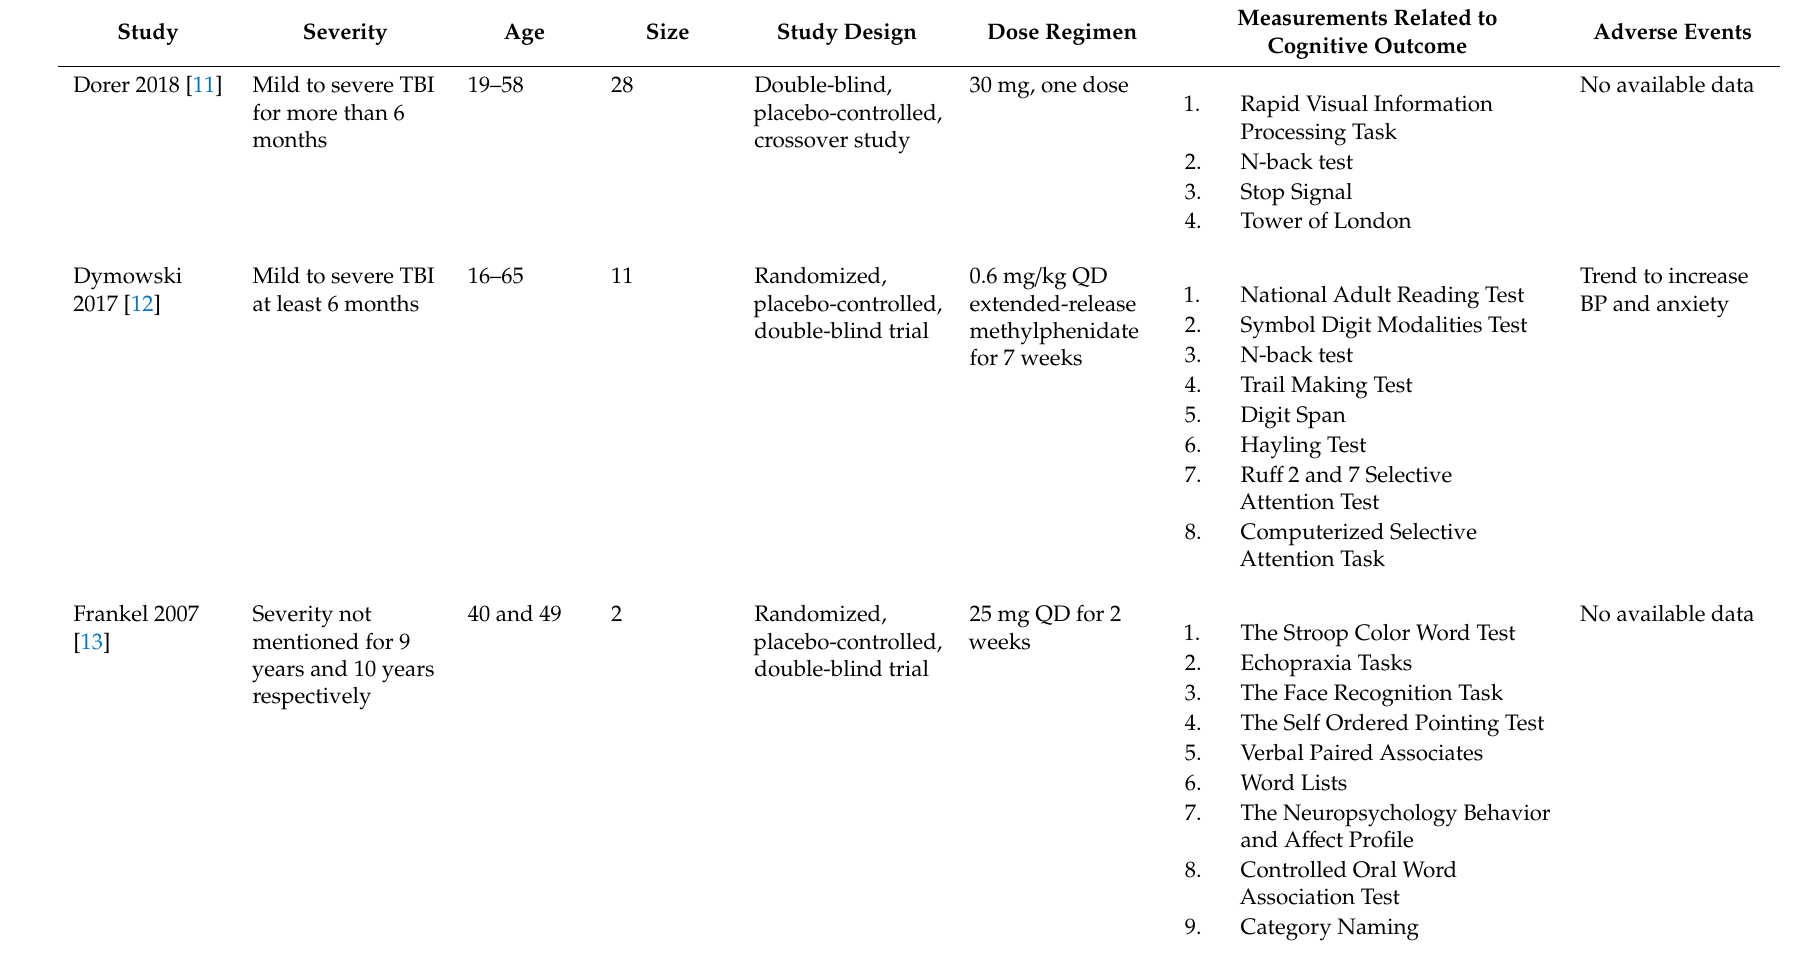
Table 1. The detailed characteristics of included